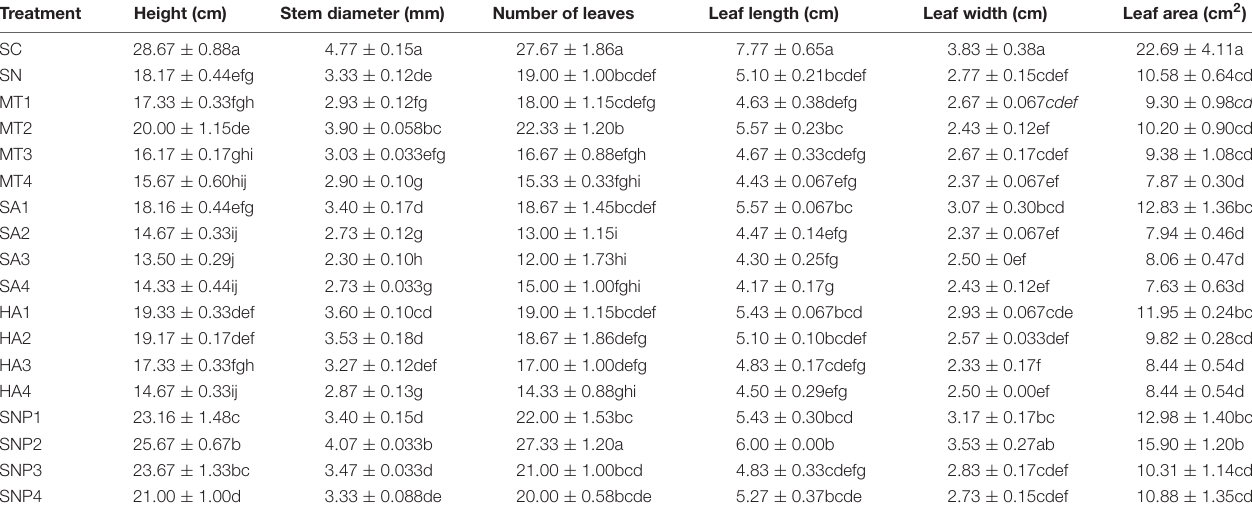
TABLE 2 | Effects of exogenously applied growth regulators on morphological parameters of tomato under high-nitrate stress.